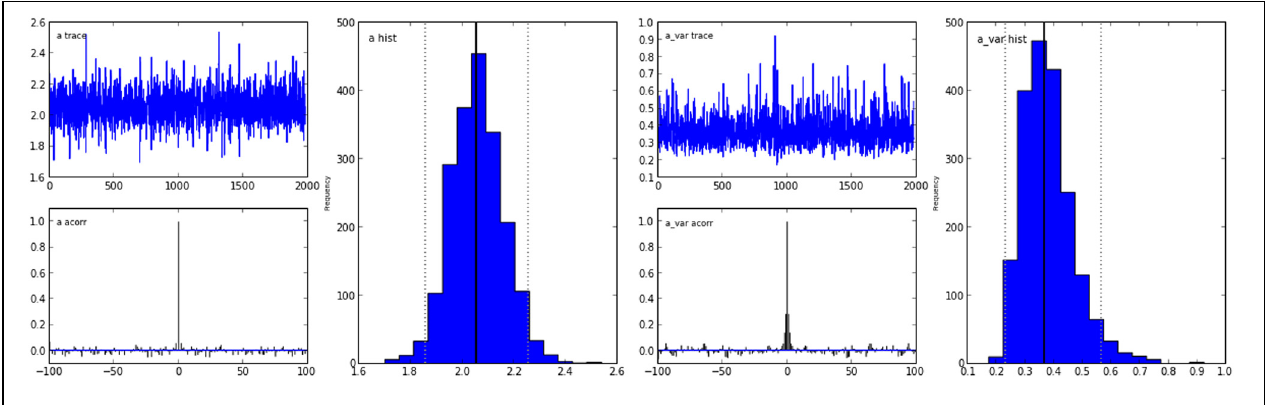
left inlay), and marginal posterior histogram (right inlay; solid black line denotes posterior mean and dotted black line denotes 2.5 and 97.5%